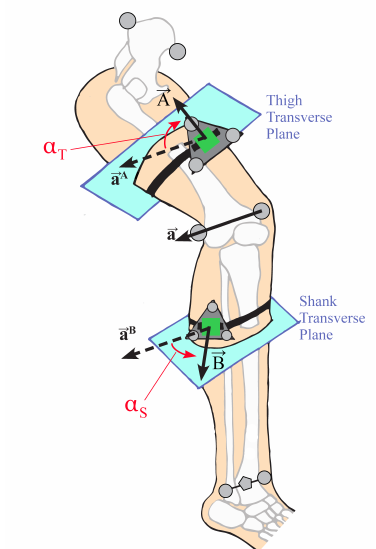
Figure 3. Illustration of the circumferential angle of the IMU (green) on the thigh ( α T ) and shank ( α S ). The knee axis (cid:126) a and its representation in the transverse planes of the thigh and shank are also shown. The pentagonal marker between the medial/lateral ankle markers represents the virtual marker that was used with the two knee markers to define the coronal plane of the shank segment. (cid:126) A and (cid:126) B represent the projection of the IMU normal vectors into the transverse planes of the thigh and shank,